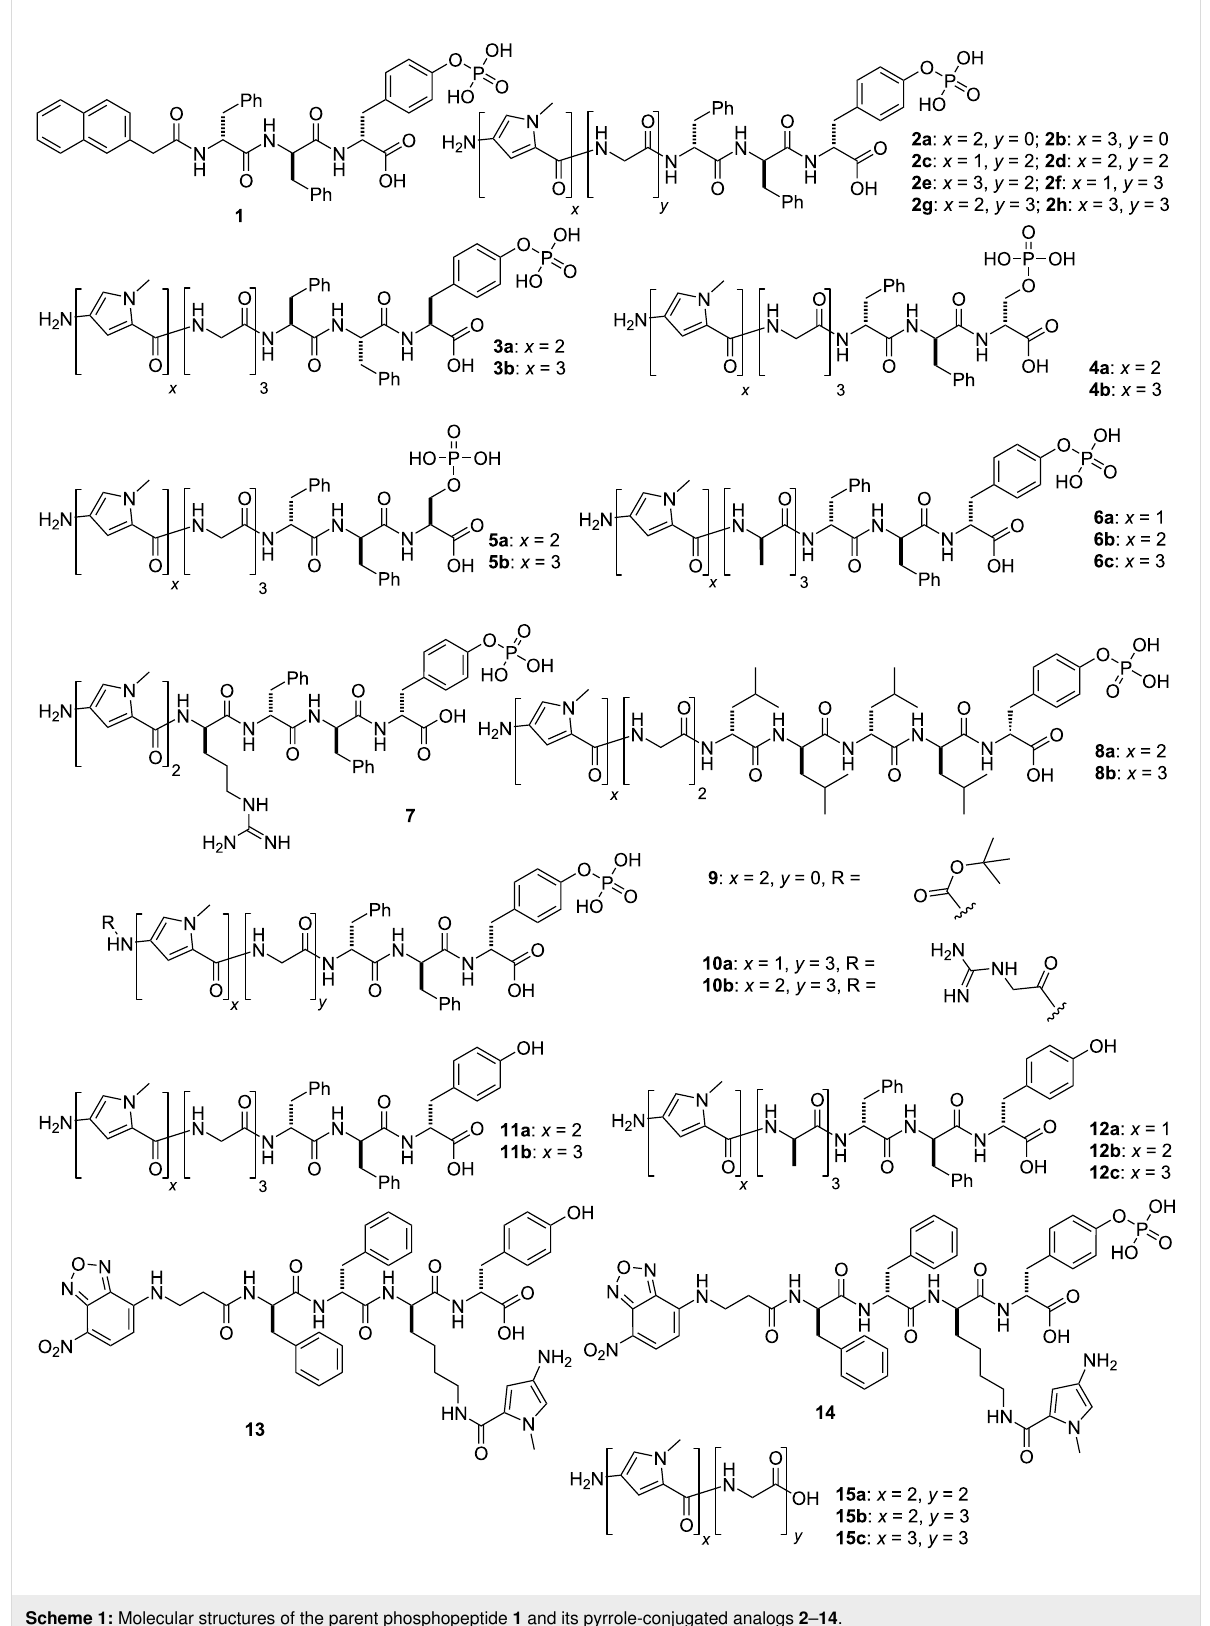
Scheme 1: Molecular structures of the parent phosphopeptide 1 and its pyrrole-conjugated analogs 2 – 14